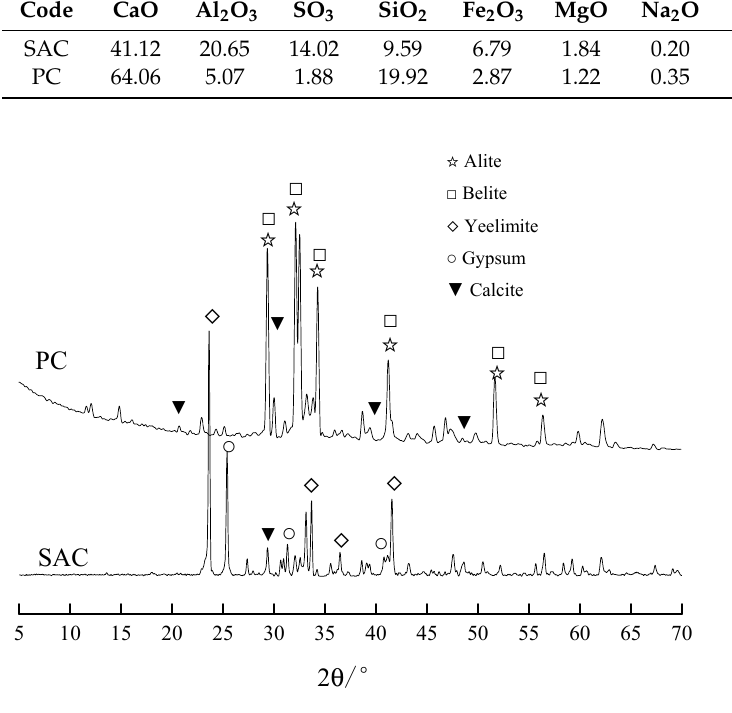
Figure 1. XRD patterns of PC and SAC.